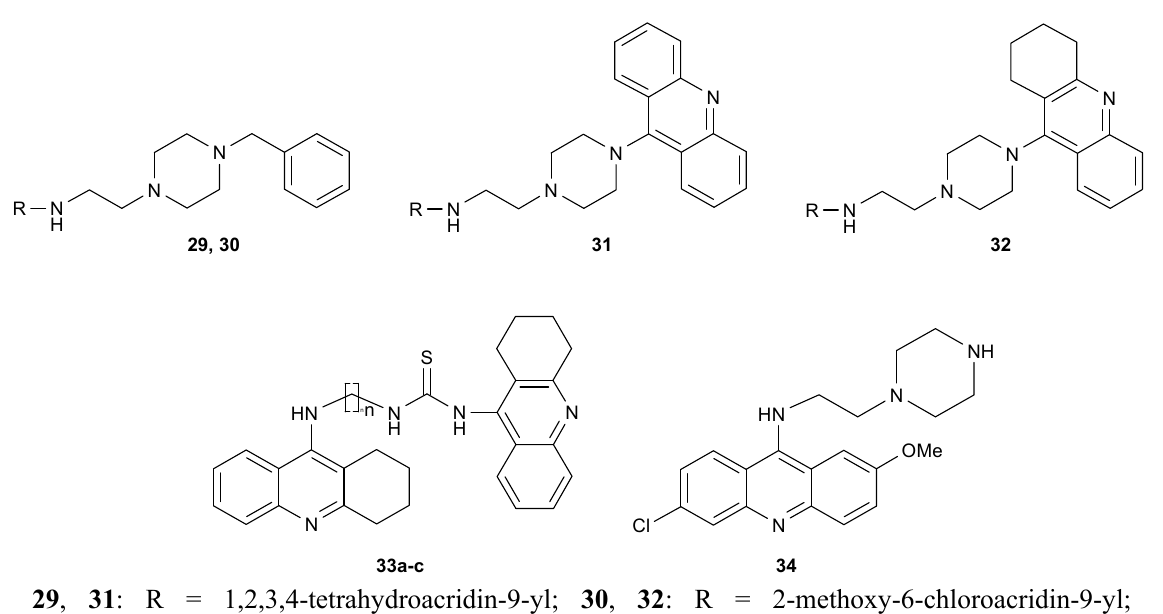
Figure 12. Heterodimeric tacrine/acridine hybrids 29–34 .